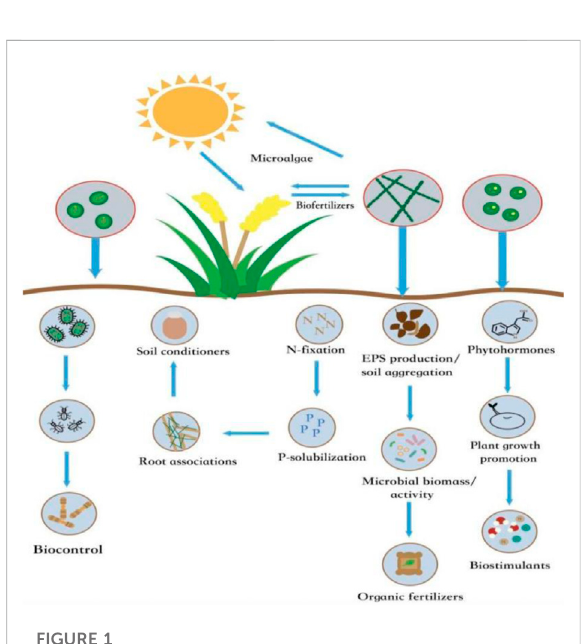
FIGURE 1 The bene fi cial mechanism of microalgae on soil and plants improvement. Permission from ELSEVIER (Alvarez et al.,